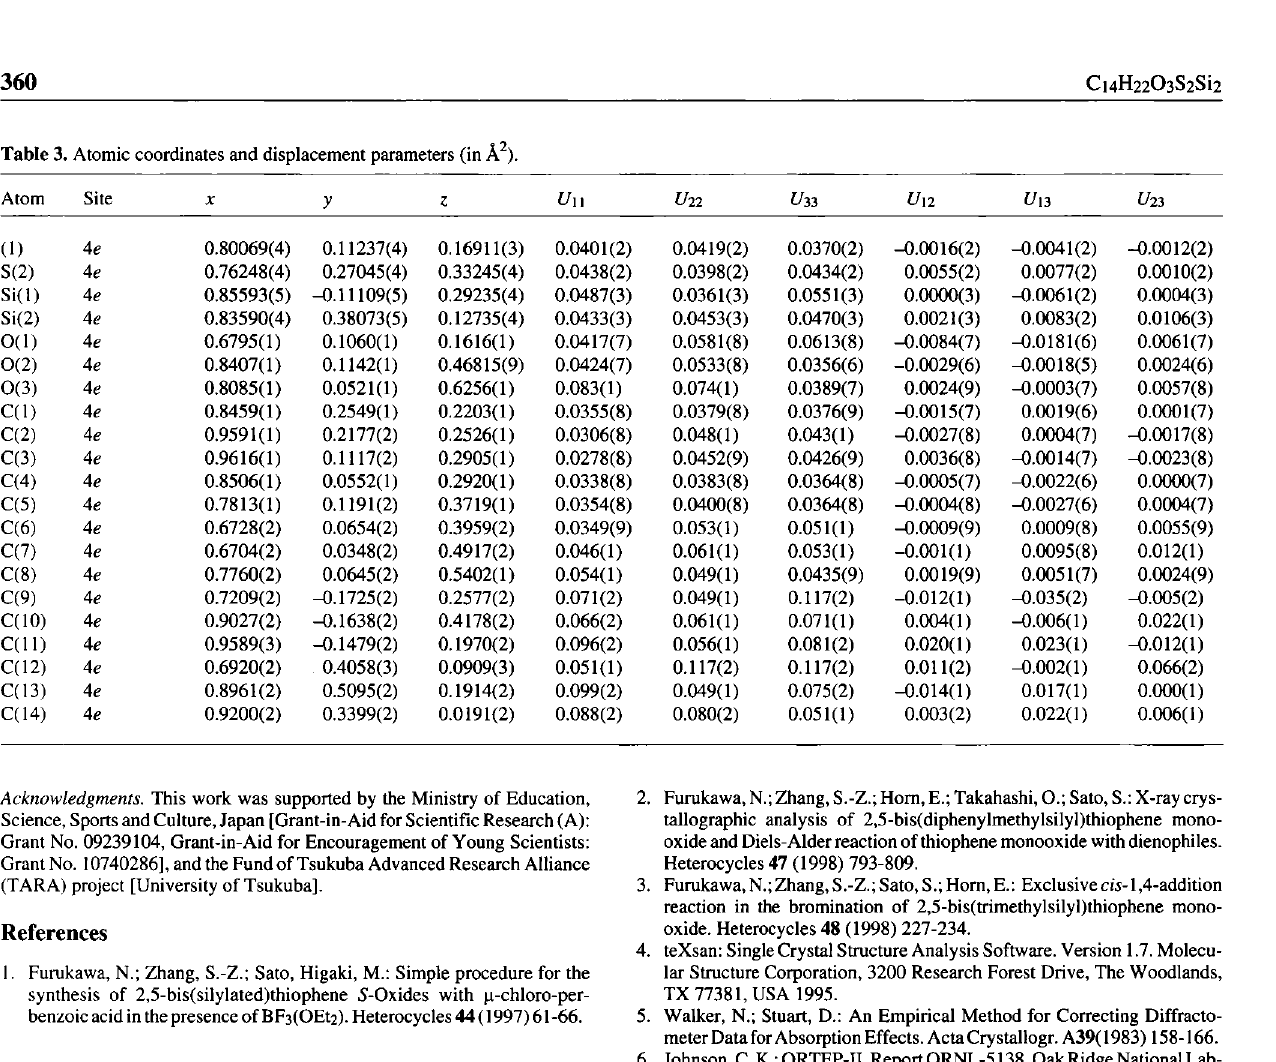
Table 3. Atomic coordinates and displacement parameters (in Ä 2